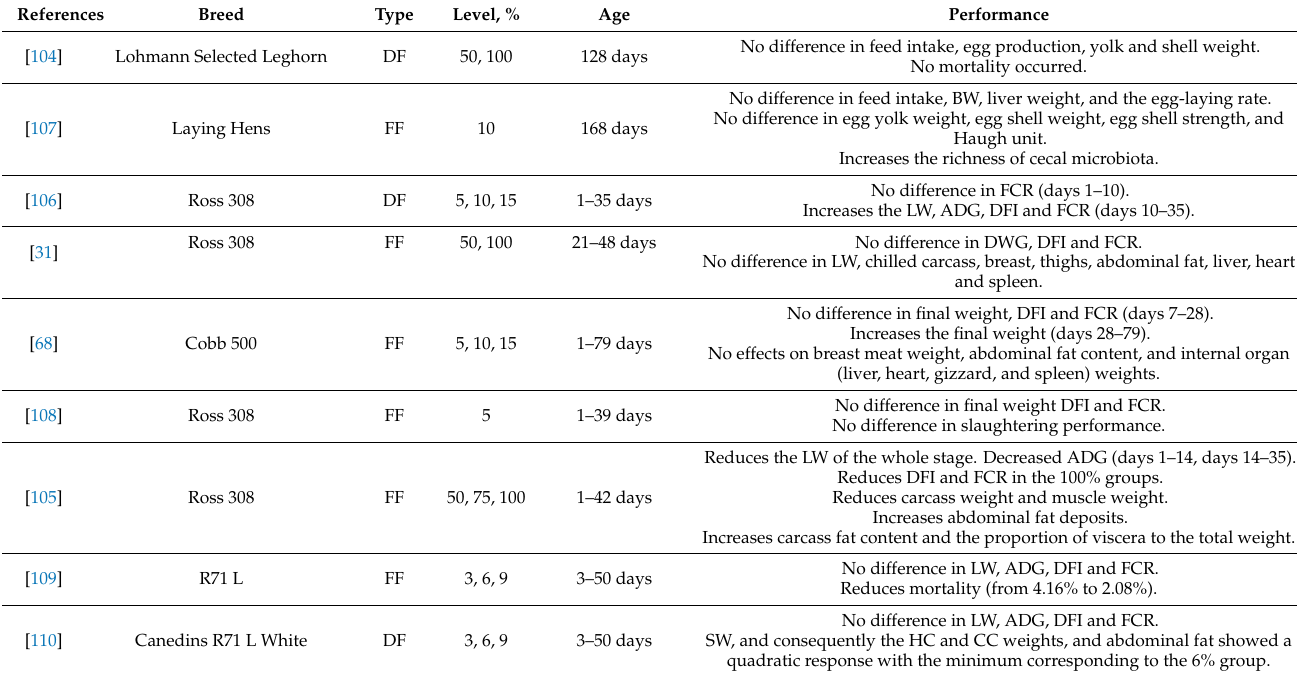
Table 5. Effects of BSFL on the growth performance of